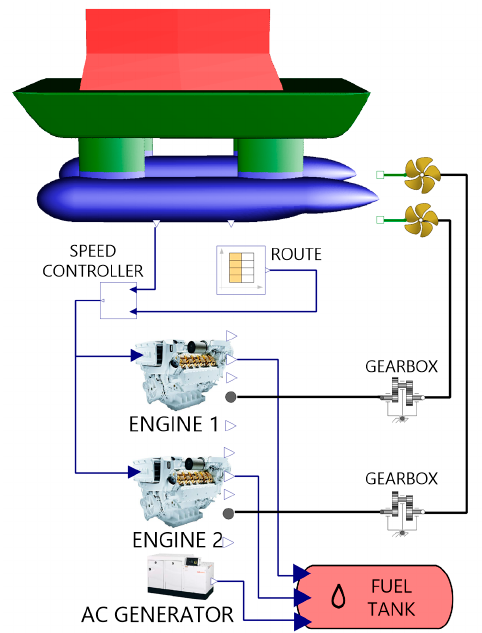
Figure 10. Model of a Diesel-Propeller SWATH II powertrain developed in Modelica.